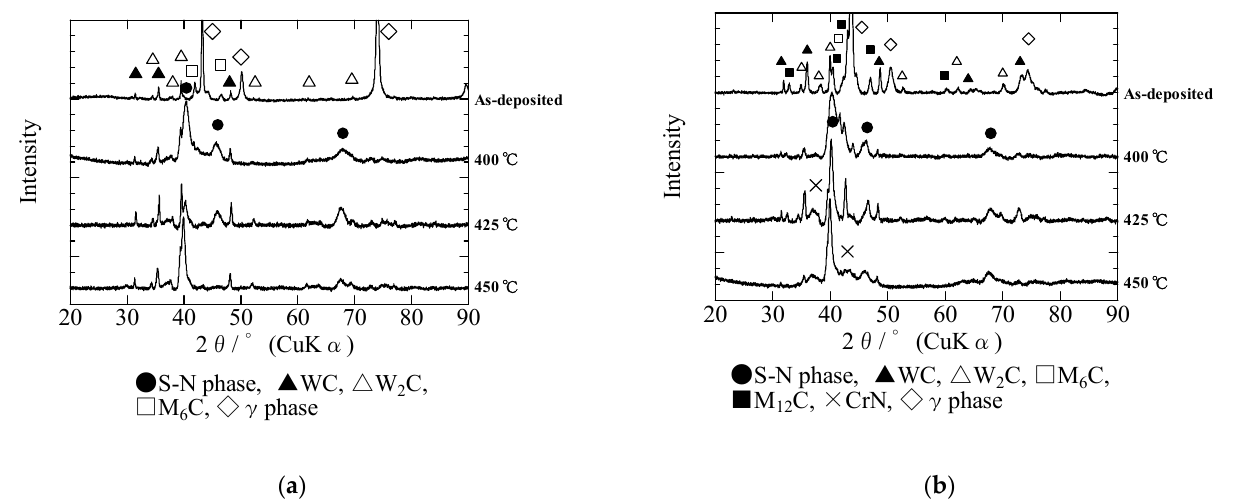
Figure 2. X-ray diffraction patterns of the AISI 316 L steel-based WC composite layers with various WC compositions and nitriding temperatures: ( a ) WC 20 wt.%, and ( b ) WC 40 wt.%.